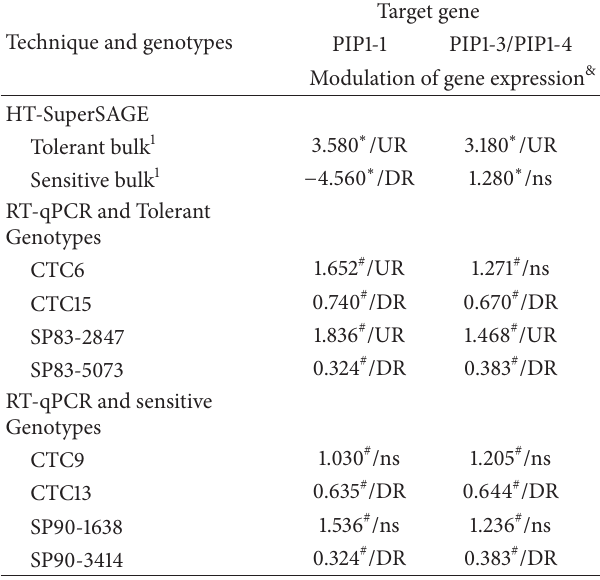
Table 6: Relative expression rates of aquaporins